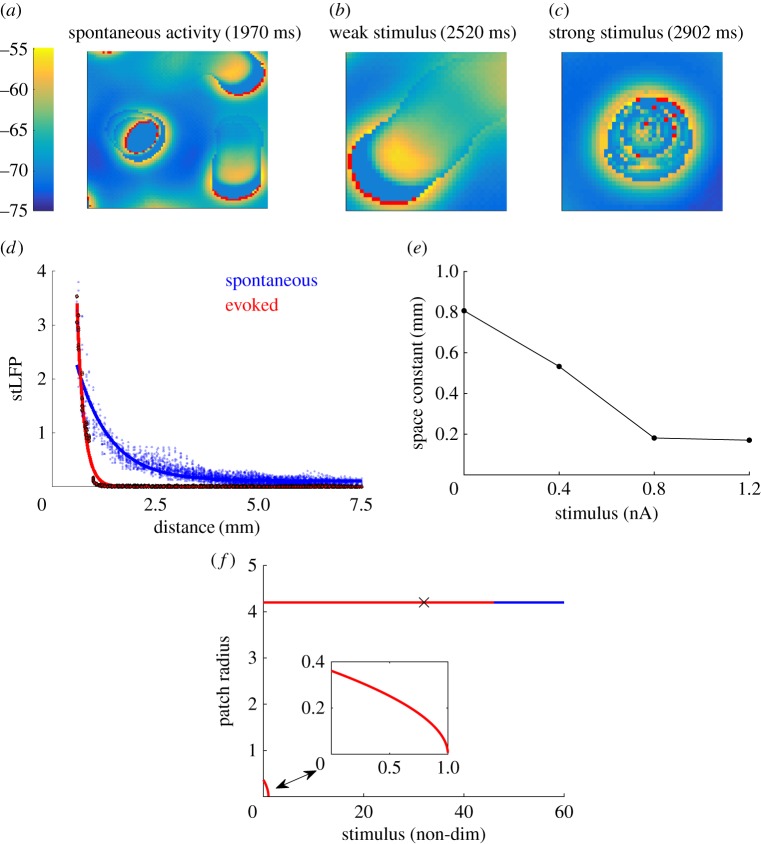
Properties of spontaneous and evoked activity patterns. (a–c) Colours in the images represent membrane potential values between −75 mV (blue) and spike threshold Vth = − 55 mV (yellow), as indicated by the colour bar, with red pixels indicating neurons that have fired within the last millisecond. Each image is of a network of size 300 × 300 neurons, but a smaller range is shown for clarity, namely an 81 × 81 subsection in (a) and a 41 × 41 subsection centred around the region of input (RoI) in (b) and (c). (a) Snapshot of the spatio-temporal patterns emerging from the balanced, spatially extended network during the spontaneous activity. These patterns take the form of multiple, localized patchy patterns and crescent-shaped propagating waves. (b) Snapshot of a propagating wave evoked by a weak stimulus (0.4 nA) within the RoI. (c) Snapshot of a localized patchy pattern evoked by a strong stimulus (1.2 nA) within the RoI. (d) Spike-triggered local field potential (stLFP) as a function of distance from the RoI for the spontaneous activity (blue dots) and activity evoked by a strong stimulus (black dots). The blue line and red line are exponential fits to the data for the spontaneous and evoked activity, respectively. (e) The average propagation range, as characterized by the space constant, of the response patterns varies as a function of stimulus strength. (f) Stability of two localized solutions of the firing rate model as a function of stimulus strength. The inset shows a zoomed in version of the solution with smaller radius. Red indicates values that are unstable to perturbation, while blue indicates stable values. The ‘x’ indicates the point (approx. 34) at which numerical simulations show a shift from the case in which perturbations cause propagating waves to the case in which the localized patchy pattern remains stationary.